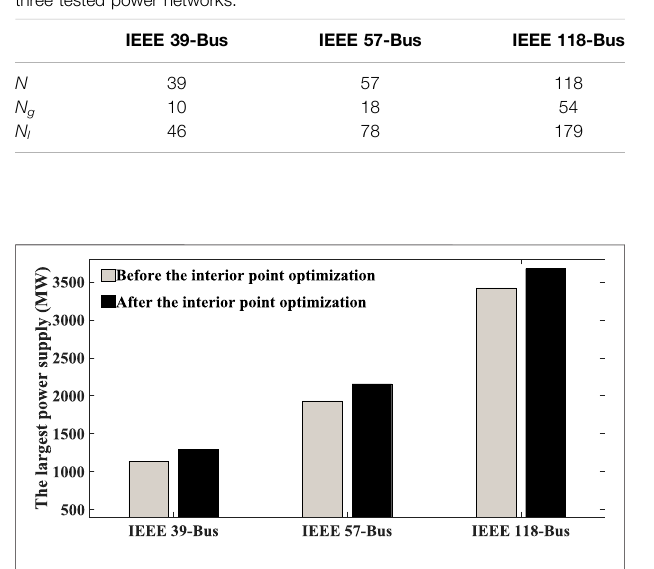
FIGURE 2 | Comparison of LPS in three IEEE Tested Cases after the cascading failure process and optimized by the interior point optimization.